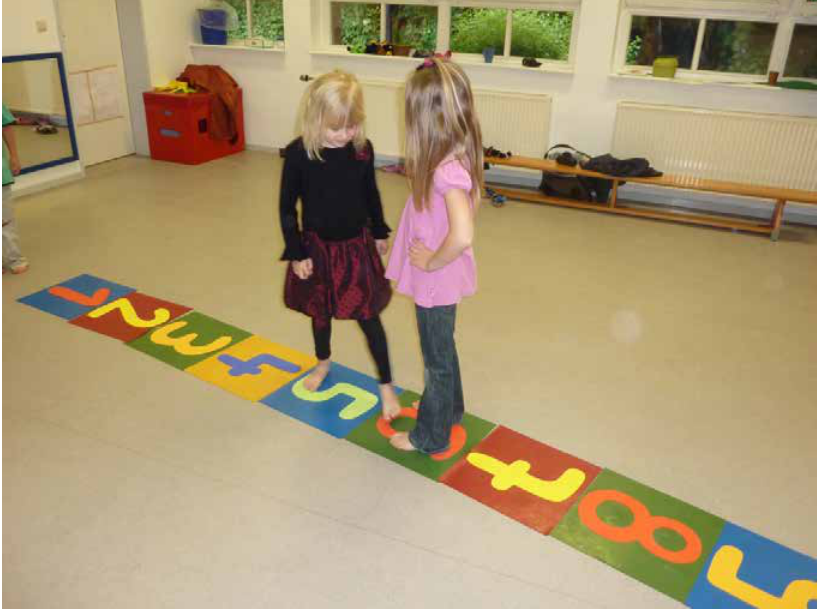
Figure 7: Children jumping according to a German counting-out rhyme (‘1, 2 Polizei –